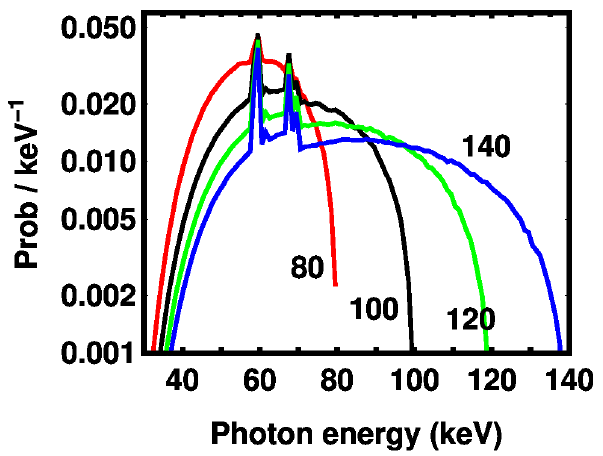
Fig 2. Spectra for tube voltages of 80 kV, 100 kV, 120 kV, and 140 kV calculated from TASMICS, [21] multiplied by a linear ramp function to represent the detector response, assuming a filter of 23.3 mm Al, which was obtained by a fit (see